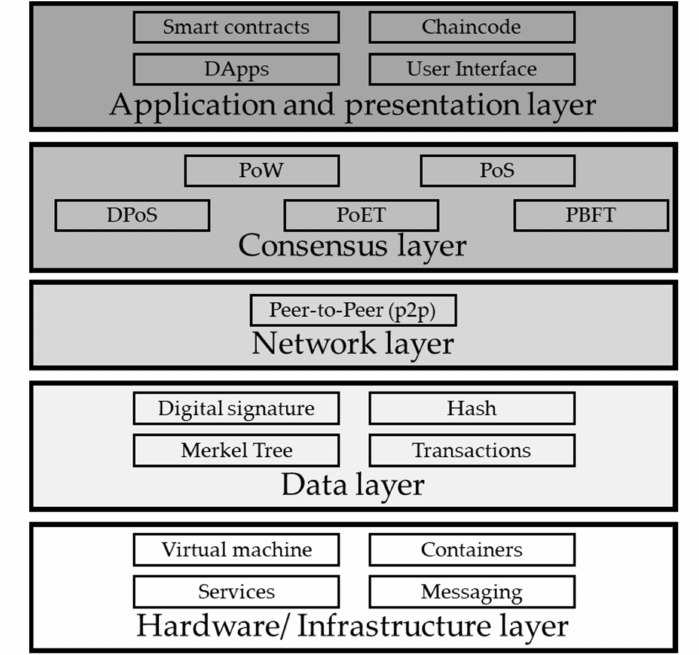
Figure 2. Layers of a blockchain